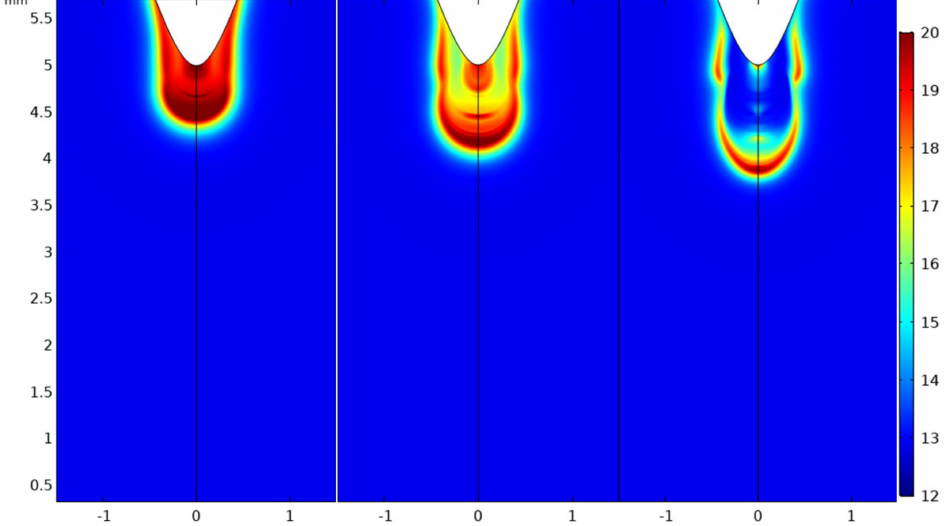
Figure 8. 2D surface plot of electron density profile at times 0.5, 1 and 2 ns in SF 6 at atmospheric